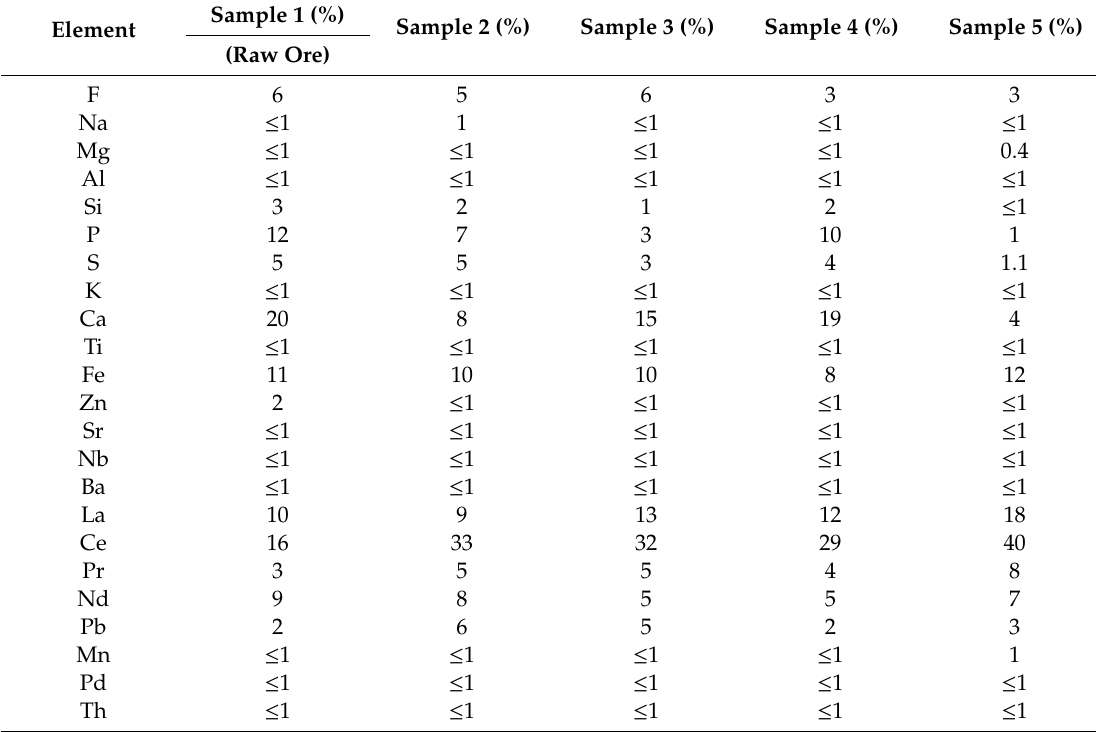
Table 1. XRF characterization of rare earth